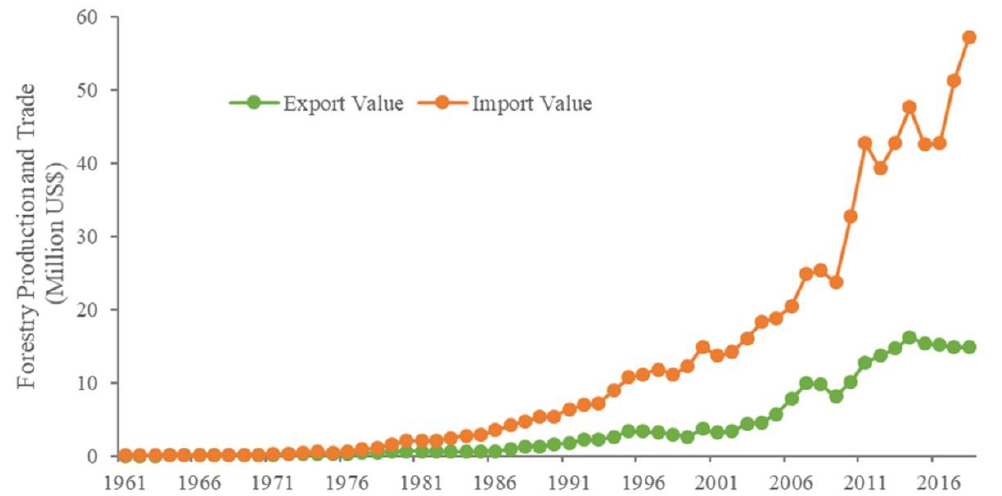
Figure 4. Imports and exports of forest products to and from China. Data source: FAO, 2017.